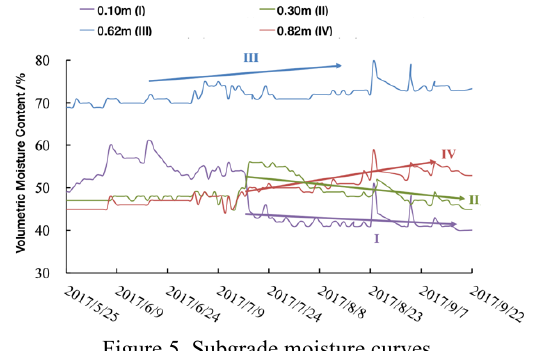
Figure 5. Subgrade moisture